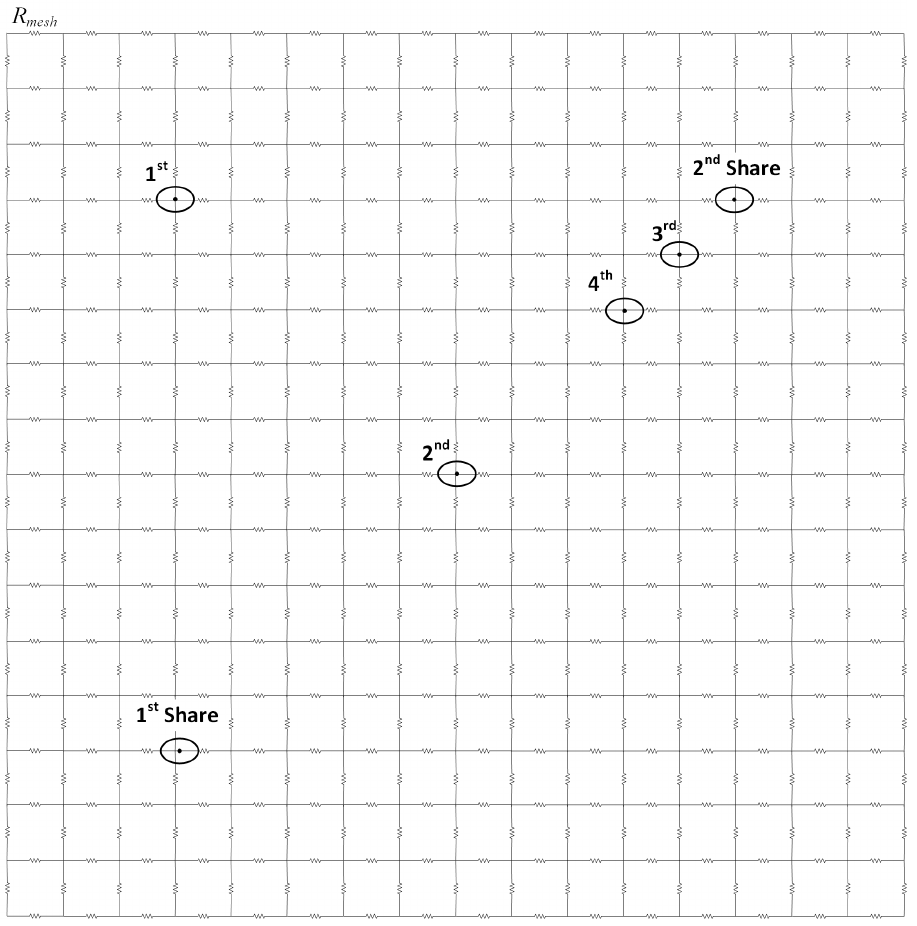
Figure 22. PDN illustrating the placement of 1st and 2nd masking shares and a single DLDO voltage regulator on one of the nodes 1st , 2nd , 3rd , or 4th